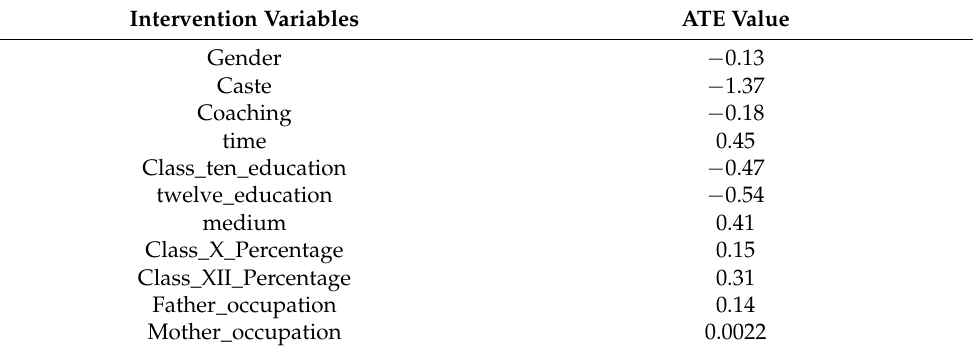
Table 9. Average treatment effect values between intervention and response variables.